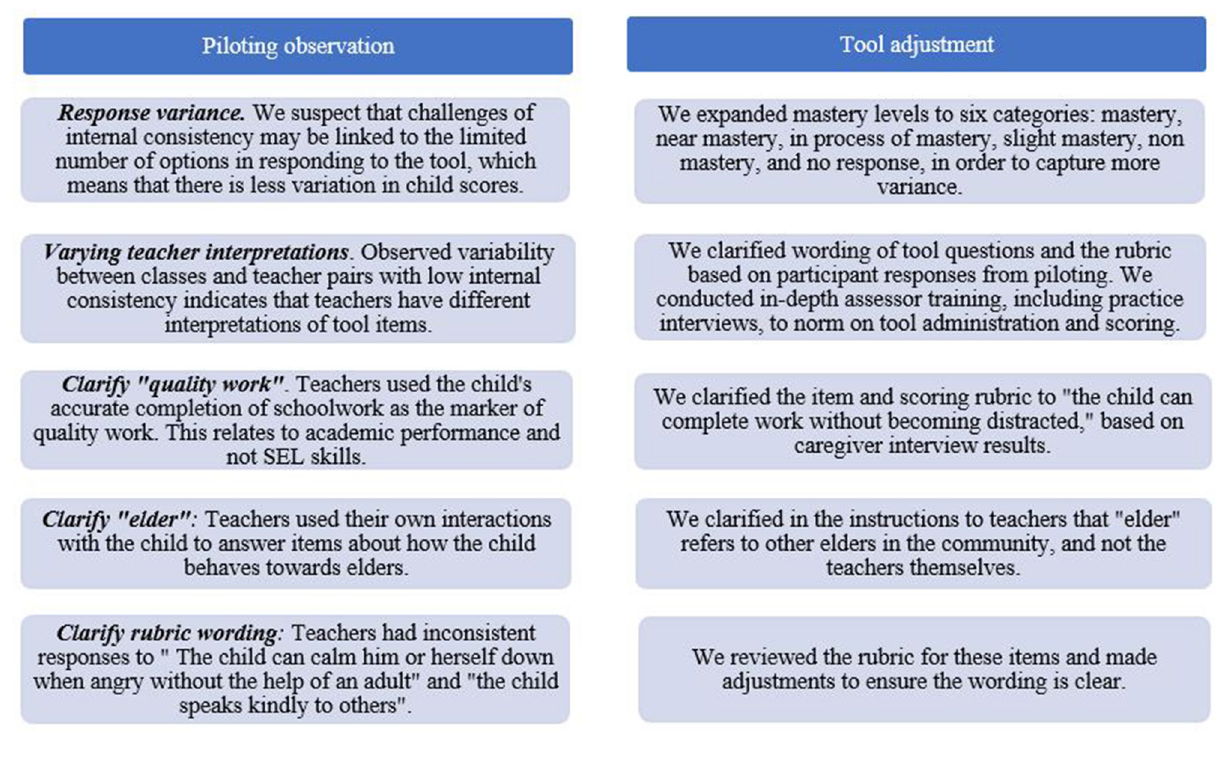
FIGURE 3 | Updates to teacher tool